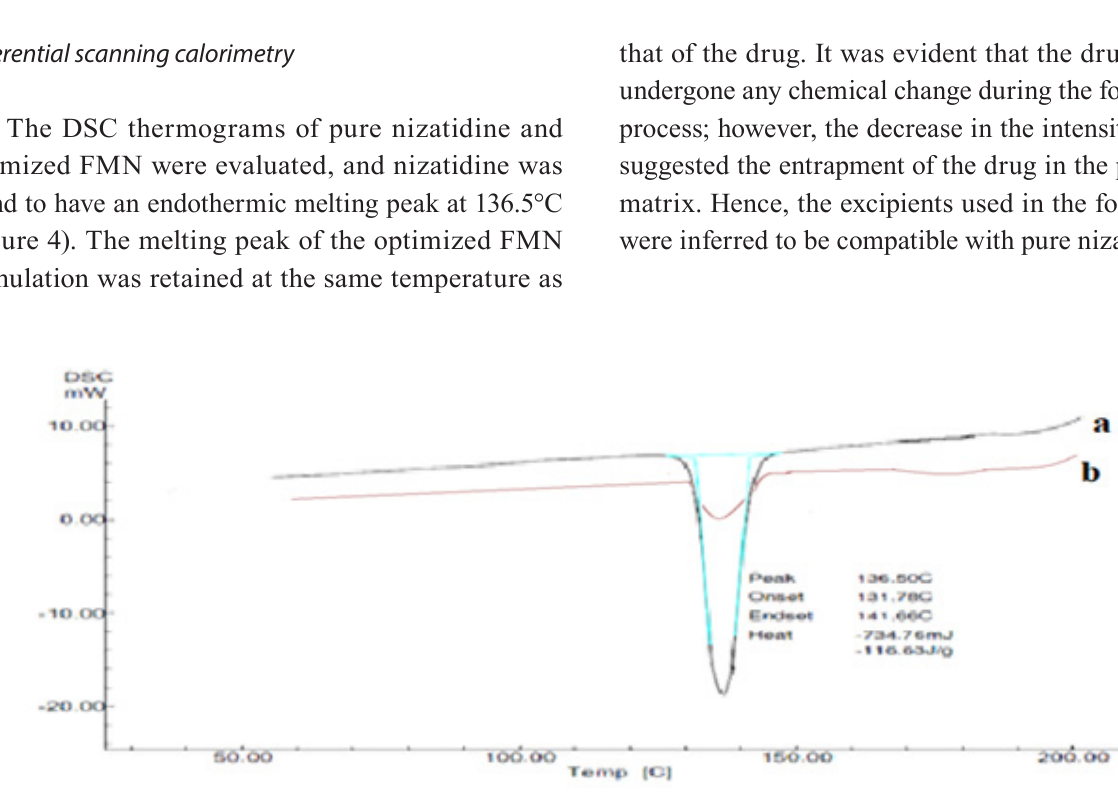
FIGURE 4 - DSC thermograms of pure drug (a) and optimized formulation